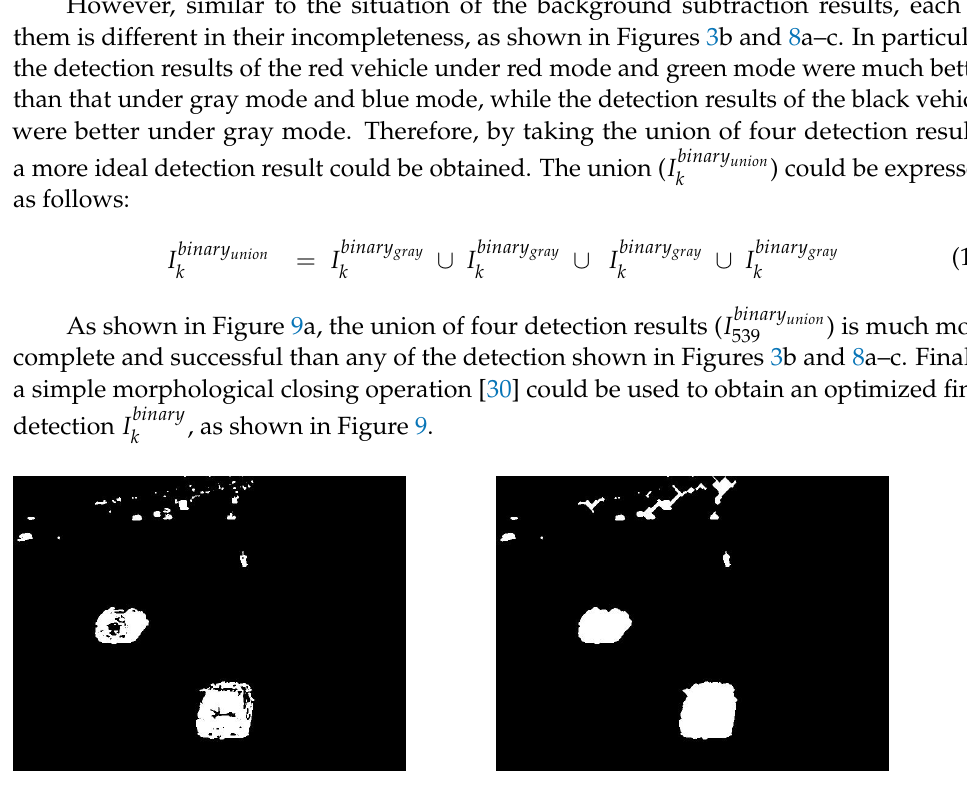
). ( b ) Optimized final 539